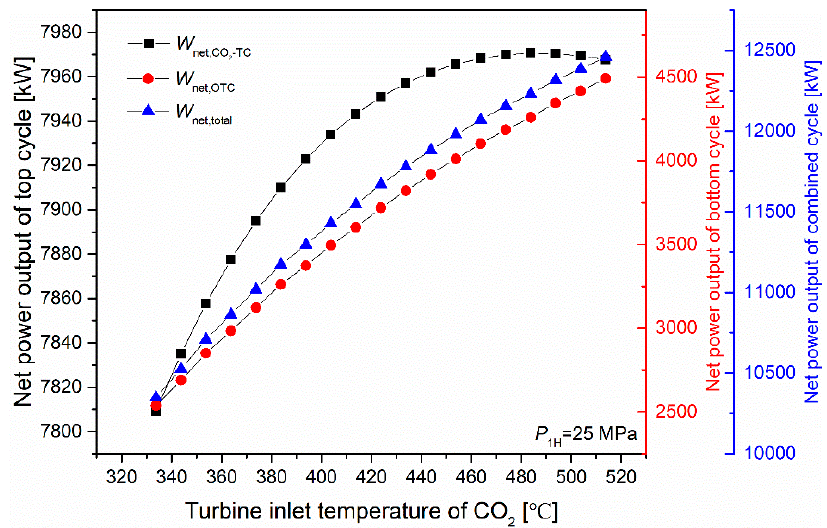
Figure 12. Variations of net power output with turbine inlet temperature of CO 2 for CO 2 -TC/OTC.